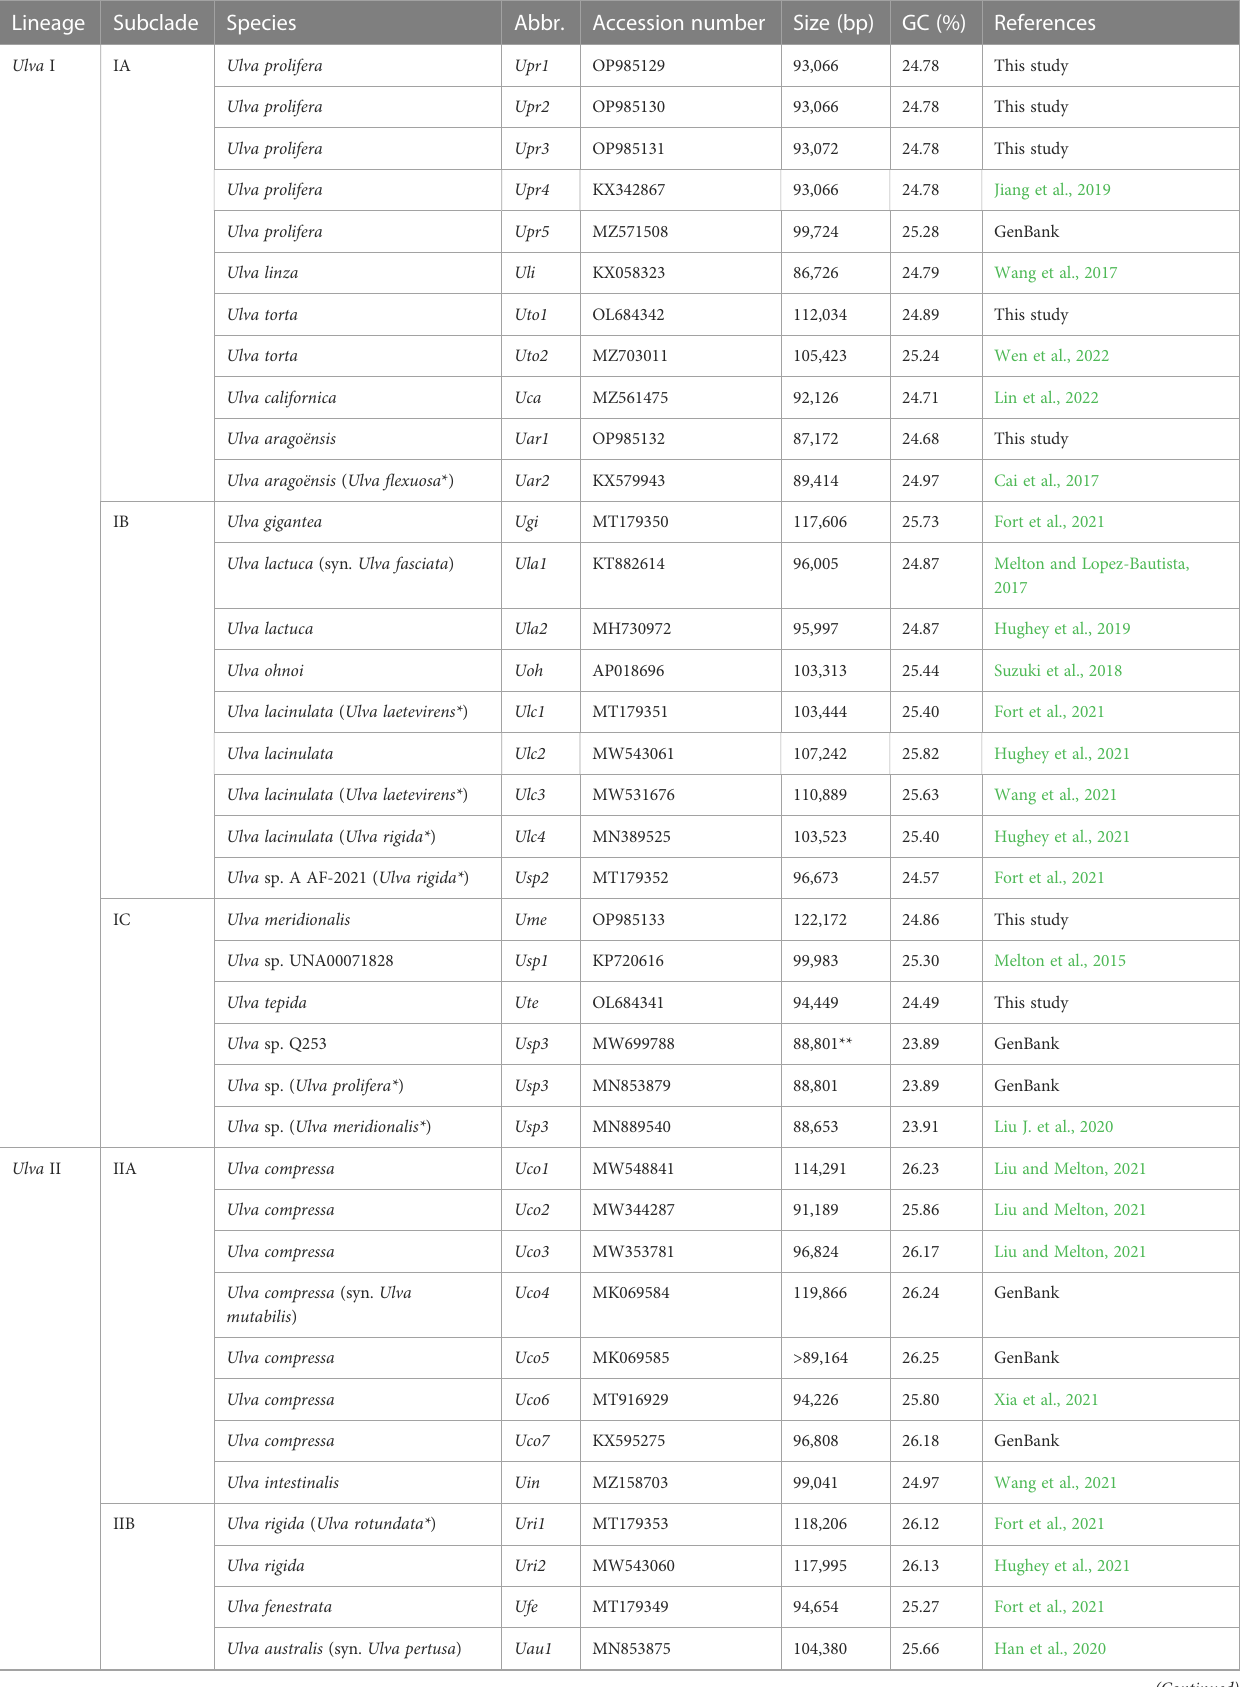
TABLE 1 The sequenced 40 plastomes of Ulva species for comparative